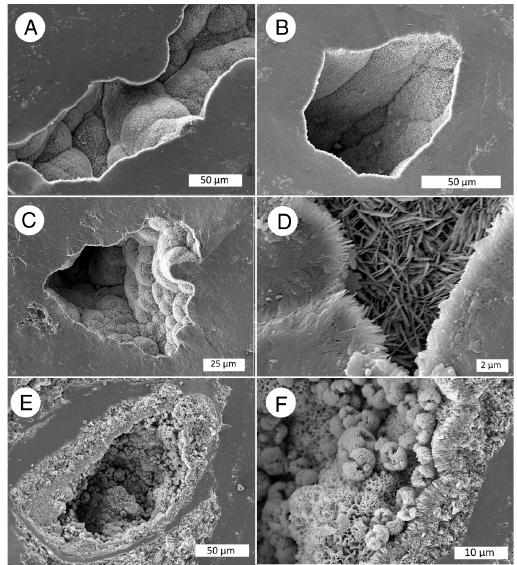
Figure 16. SEM images of opalized wood. ( A ) Sample S-4 showing botryoidal opal-CT lining a small cavity. ( B ) Sample S-4, oblique transverse view of opal-A mineralized wood with a vessel that contains a thin lining of opal-CT. ( C ) Similar features are present in sample S-3. ( D ) High magnification view of opal-CT in sample S-2, showing bladed crystals. ( E , F ) Vessel containing hemispherical masses of opal-CT lying on a botryoidal opal-CT layer. The smooth surrounding material is opal-A.